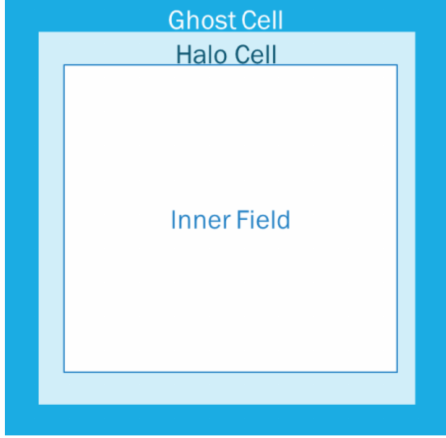
Figure 6. Schematic of domain decomposition.